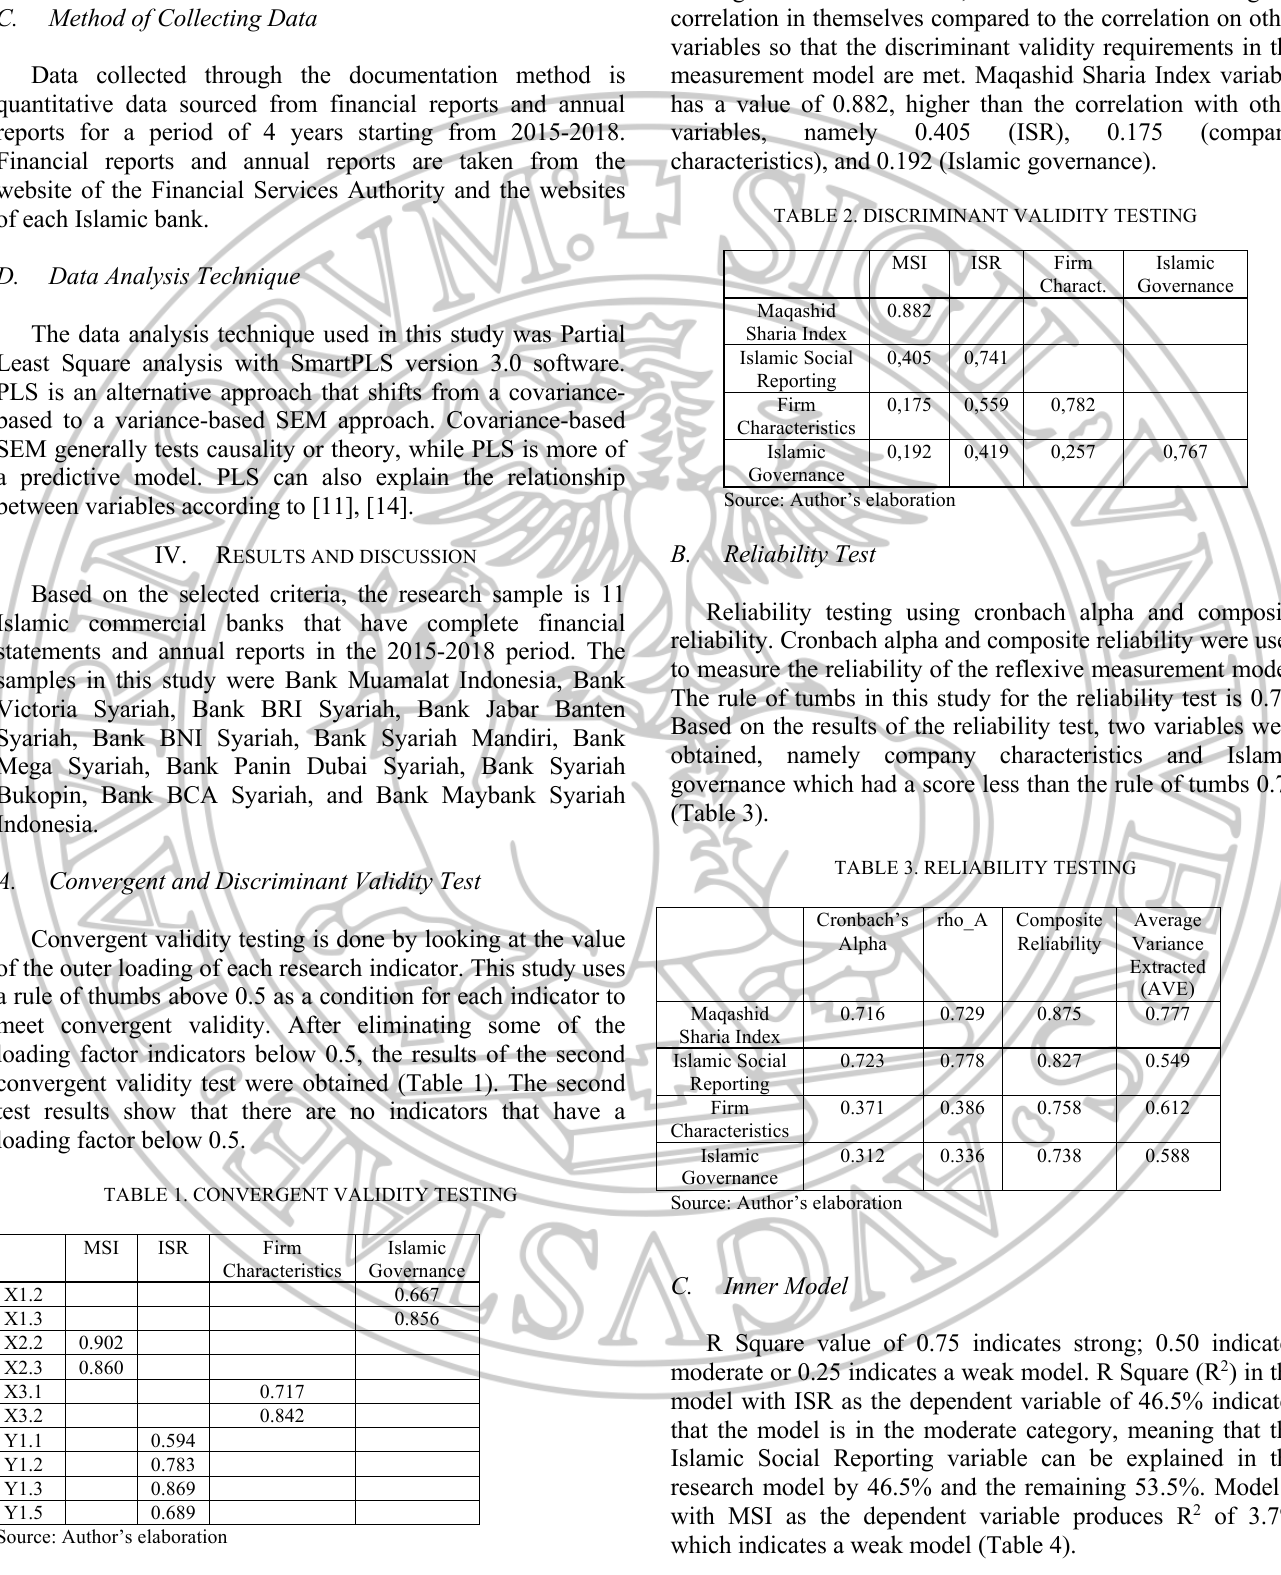
TABLE 1. CONVERGENT VALIDITY TESTING